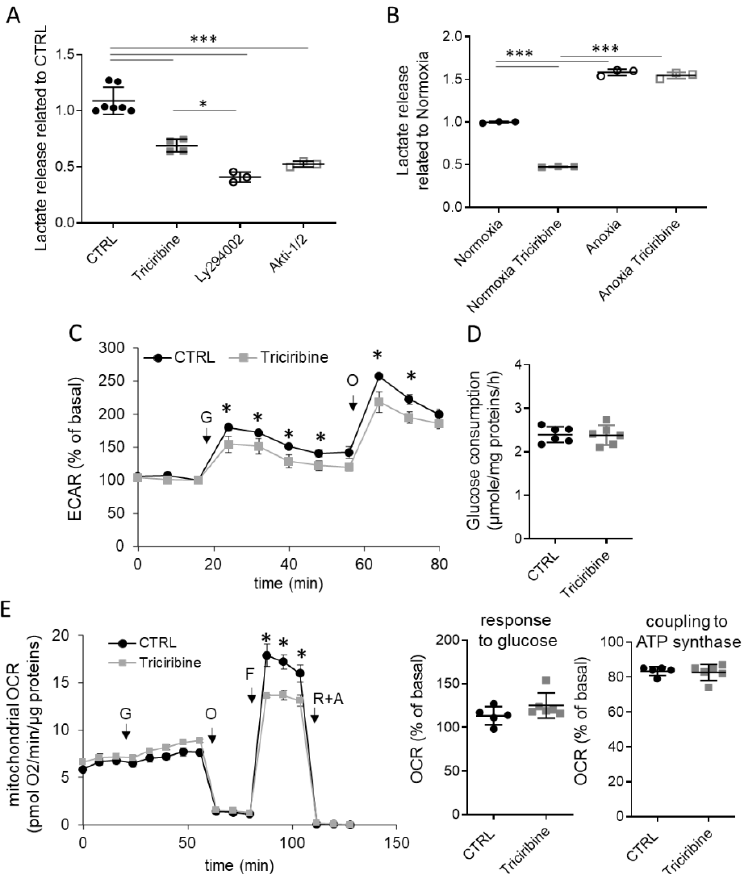
Figure 3. Akt inhibition affects glucose metabolism without modification of oxidative phosphory- lation. PCT cells were treated or not 24 h with triciribine (1 µ M), Akti-1/2 (10 µ M) and Ly294002 (50 µ M) and used for different analyses. ( A , B ) Measurement of lactate media content related to whole cell proteins content at the end of treatment ( A ) or after an additional 24-h exposition to normoxia or anoxia ( B ). ( C ) Cells were analyzed using Seahorse technology to evaluate extracellular acidifi- cation. Arrows indicate injection of the different compounds (G, glucose 10 mM; O, oligomycin A 1 µ M). ( D ) Evaluation of cell glucose consumption corresponding to media glucose content decrease.